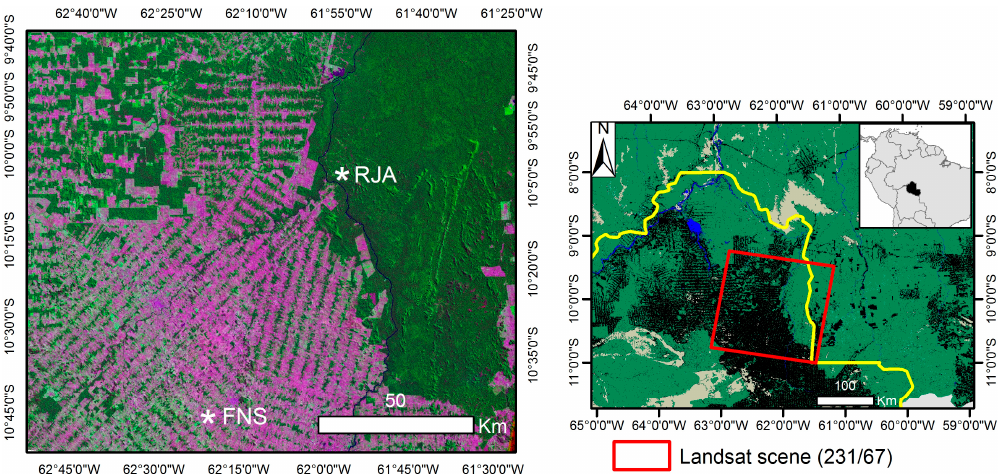
Figure 1. Flux tower sites Jarú Biological Reserve (RJA) and Fazenda Nossa Senhora (FNS) in Rondônia, the Brazilian Amazon.